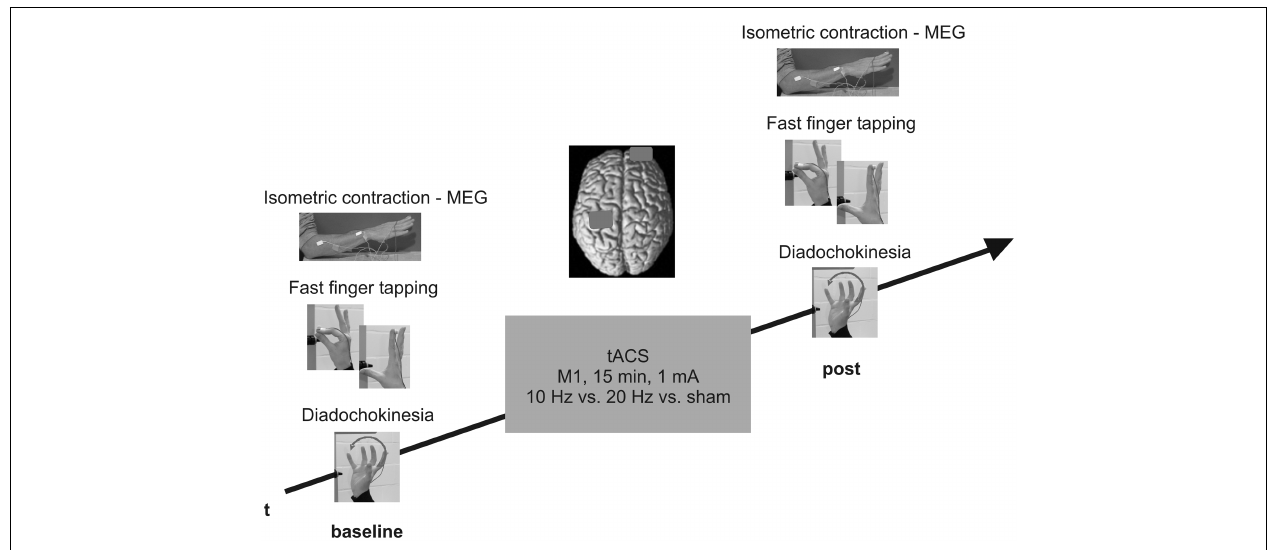
FIGURE 1 | Experimental design. Isometric contraction during MEG and fast finger tapping/diadochokinesia were investigated prior to and shortly after tACS. PD patients attended three separate sessions (10 Hz vs. 20 Hz vs. sham), control subjects received 20 Hz tACS